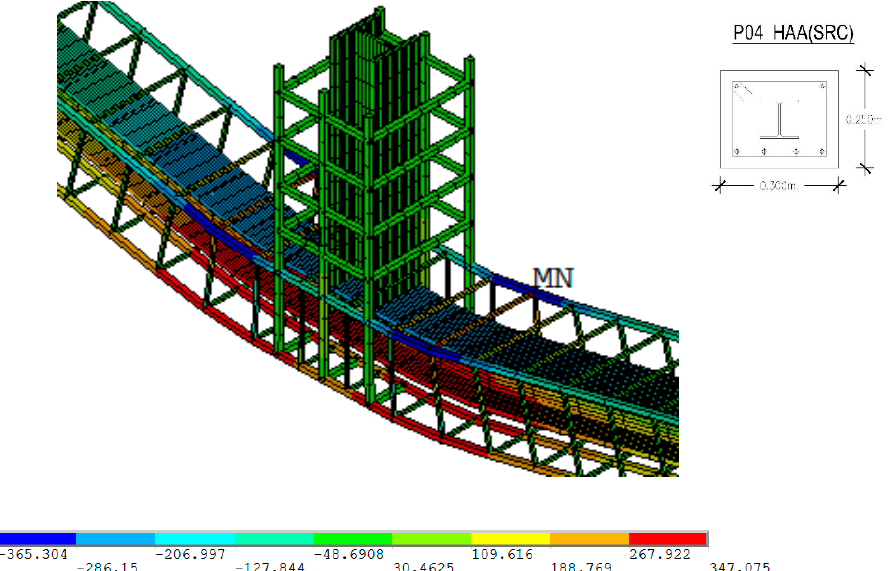
Figure 21. Stress in steel of prototype P04 simulated with a deflection of 350 mm at the center.